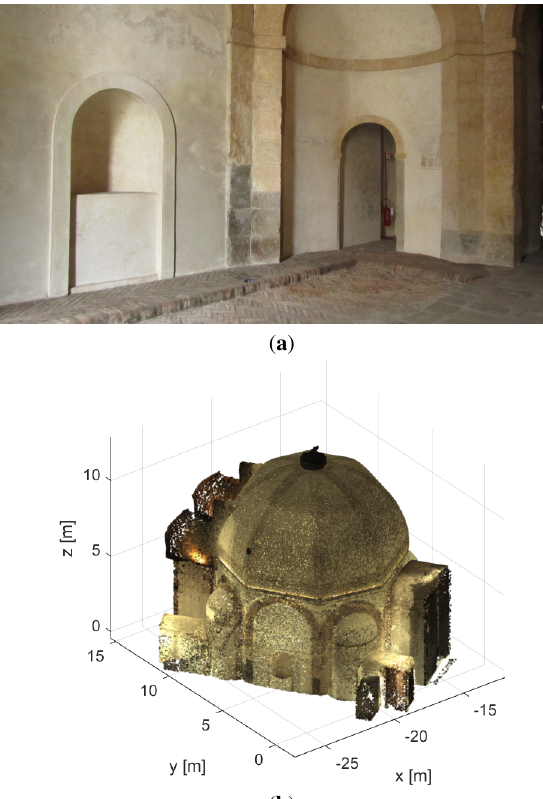
Figure 4. Comparison of UWB anchor positions: surveyed (red dots) and obtained by means of the self-positioning procedure (blue dots). Case studies: ( a ) Impossible bastion, ( b ) Savonarola